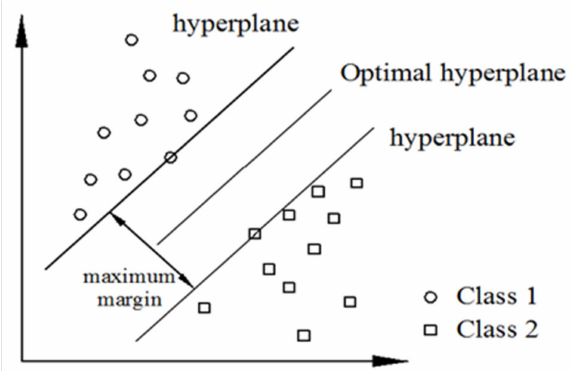
Figure 5. Schematic diagram of